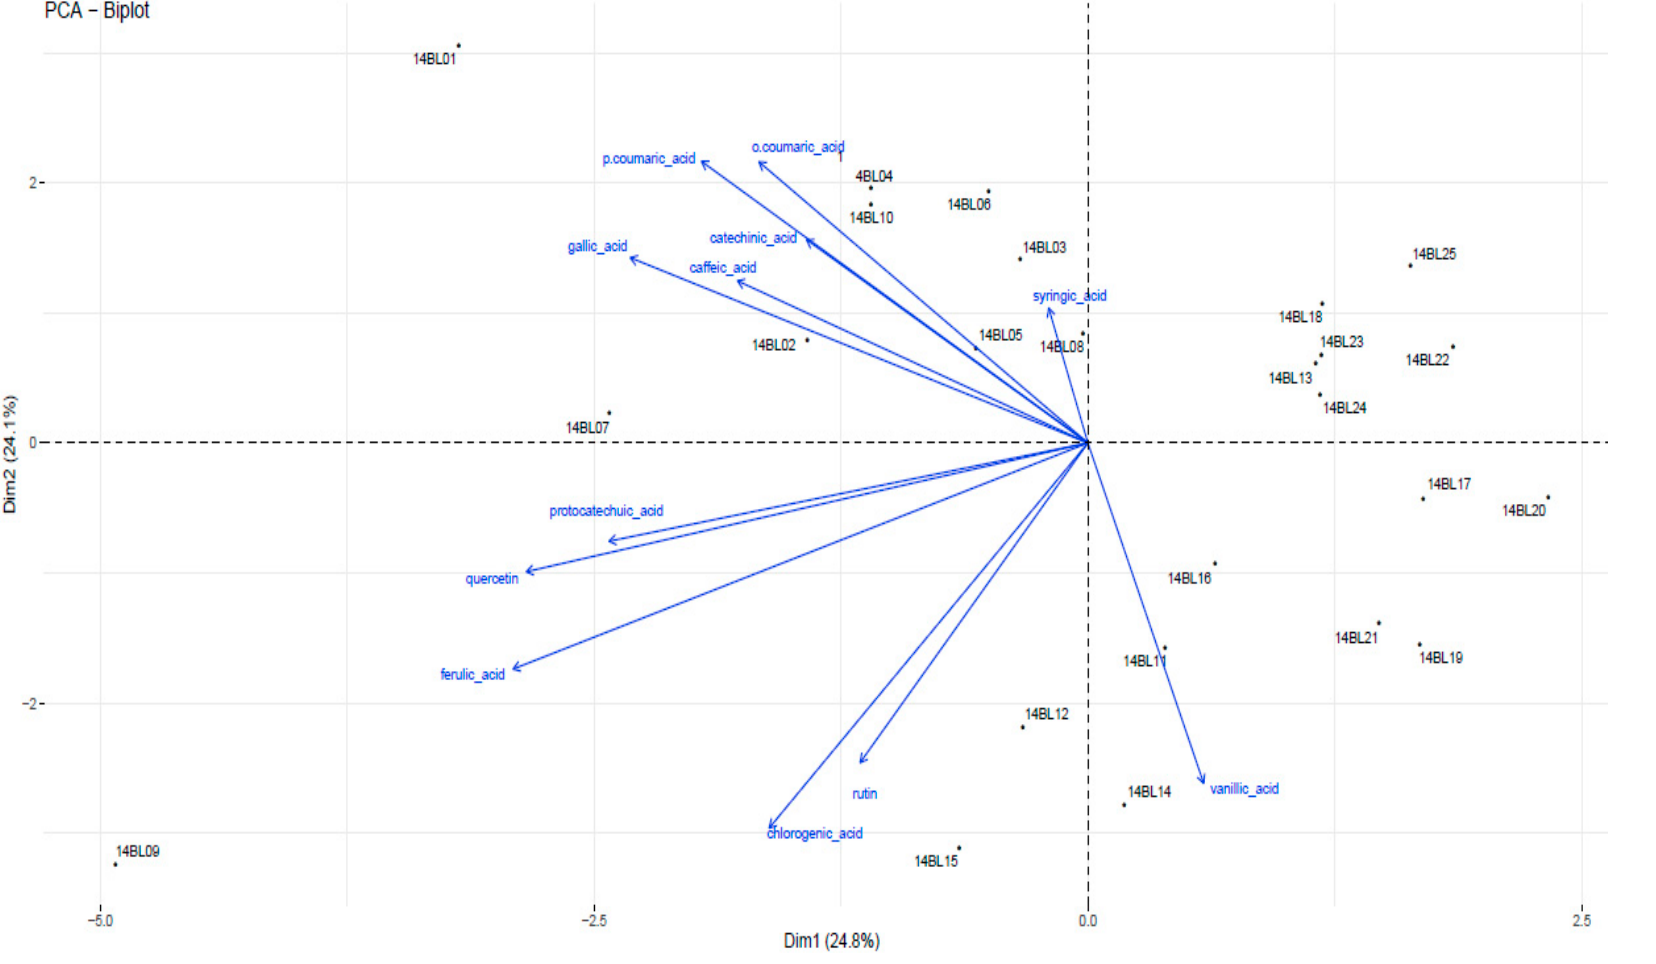
Figure 2. Diversity of genotypes in terms of phenolic compounds by PCA analysis.